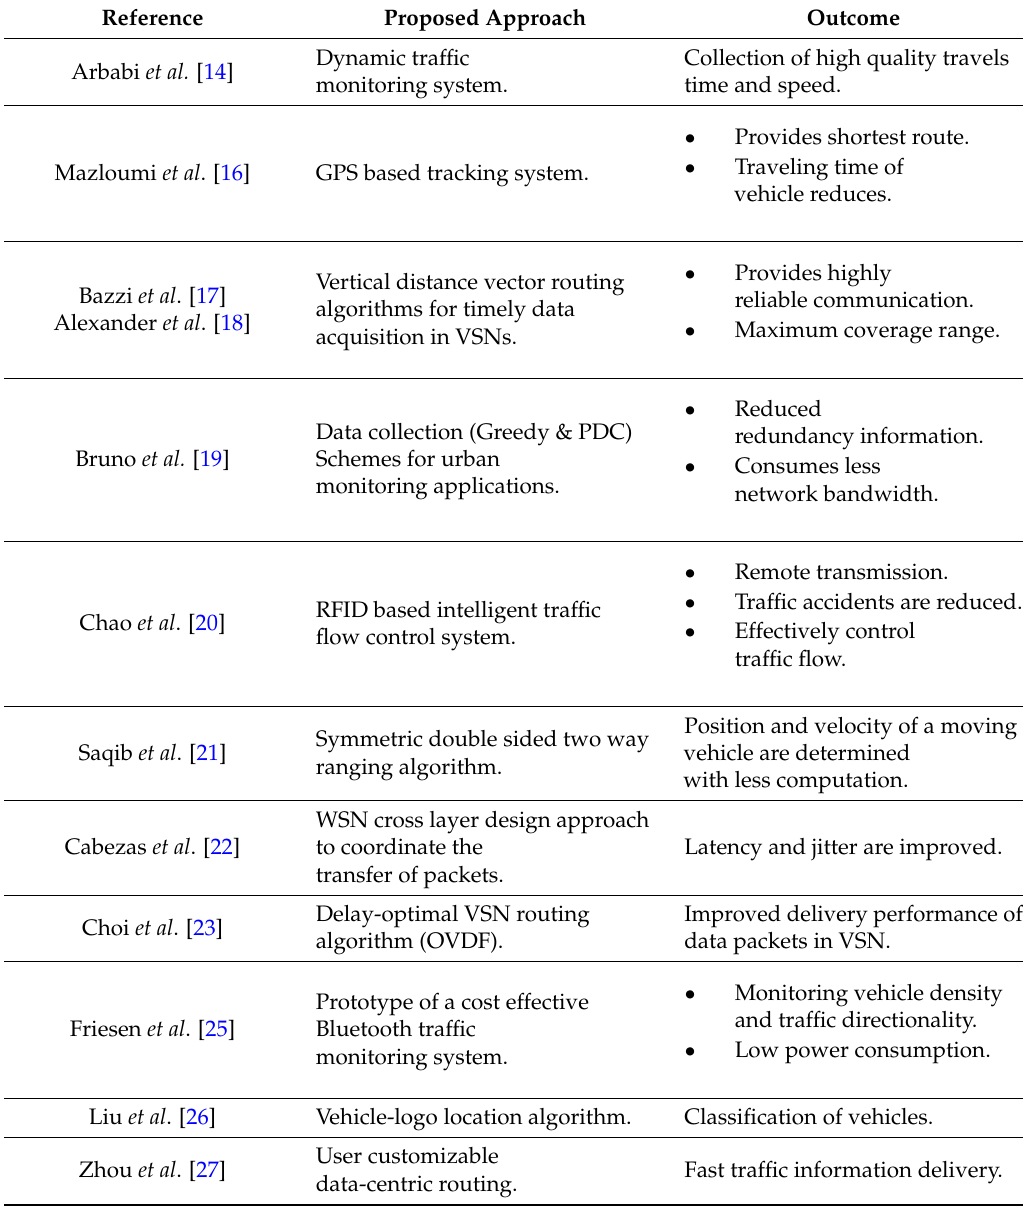
Table 5. Summary of architectures, data collection schemes and routing